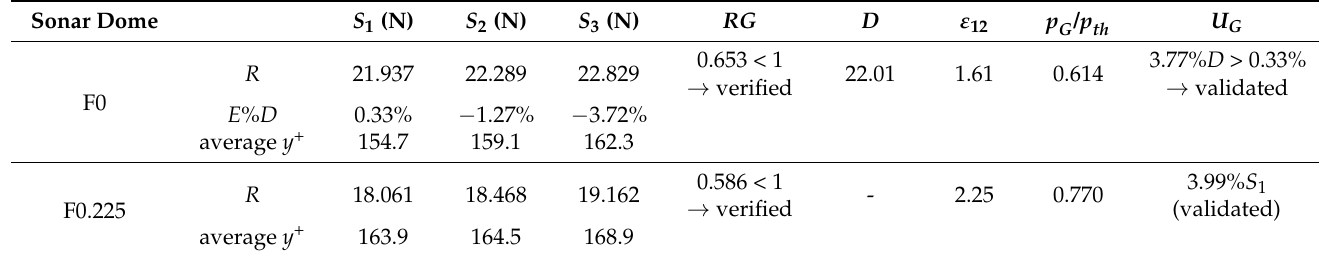
Table 4. V&V result for the ship’s total resistance R with F0 and F0.225 sonar